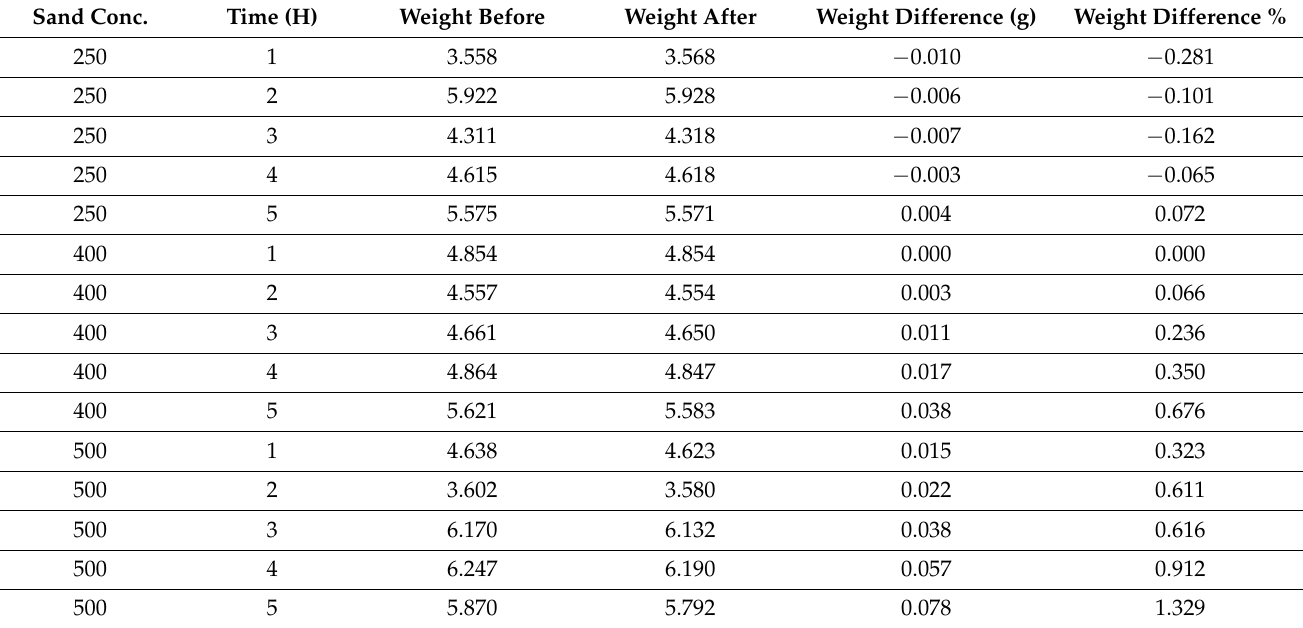
Table 3. Test data at a flow rate of 0.01 m 3 /min + (10 wt.% Cl). Sand